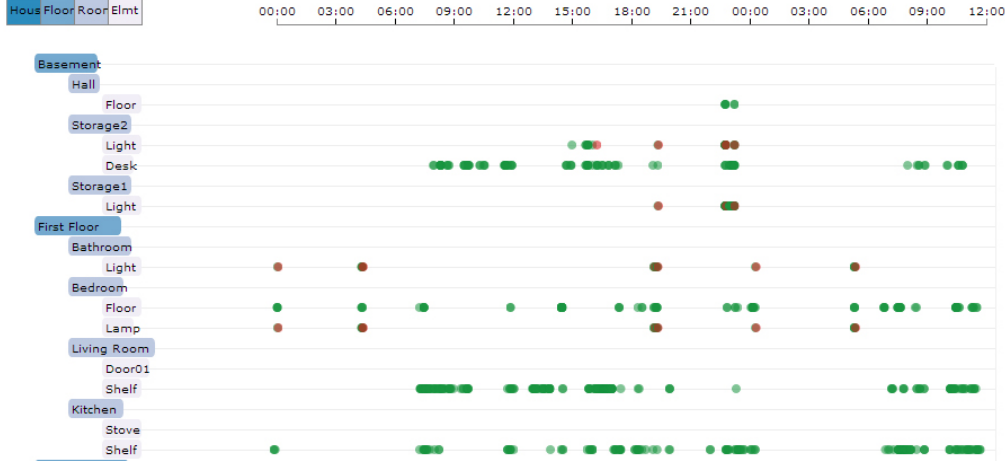
Figure 9. A snapshot from a period of 36 h in one household. The devices, their position in the household and their activation patterns are shown. Devices that have two person-triggered states (e.g., can be switched on and off) are represented by dots with two different colors (green = on; and red = off). Devices that are only triggered in the on state, for example motion sensors, only have a green color (on), because they are switched off automatically.